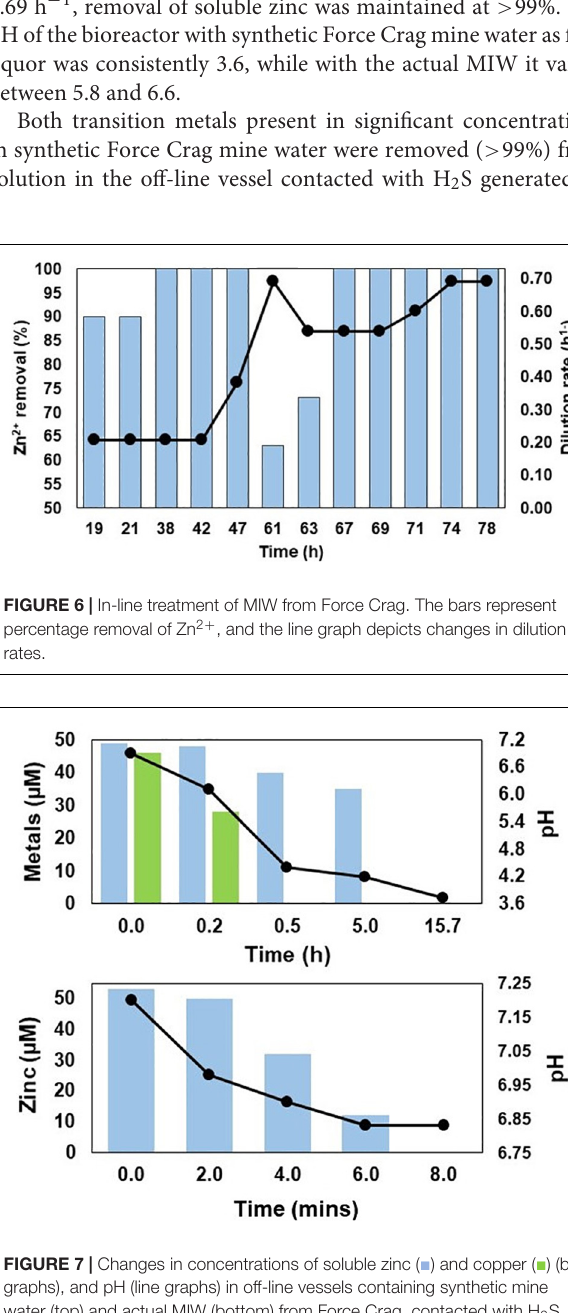
Frontiers in Environmental Science |